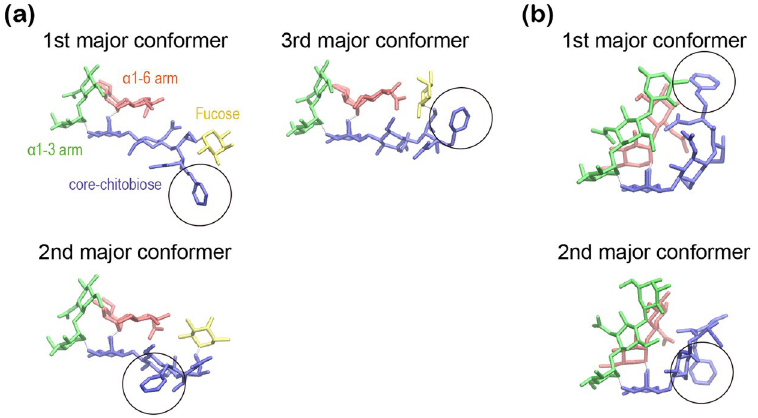
Figure 4. Comparison of major conformers: ( a ) three major conformers in G0F and ( b ) two major conformers in G1(3). Blue, green, red, and yellow colors for the core chitobiose, α 1-3 arm, α 1-6 arm, and fucose residue, respectively. The pyridylamino (PA) group is marked by a black circle.